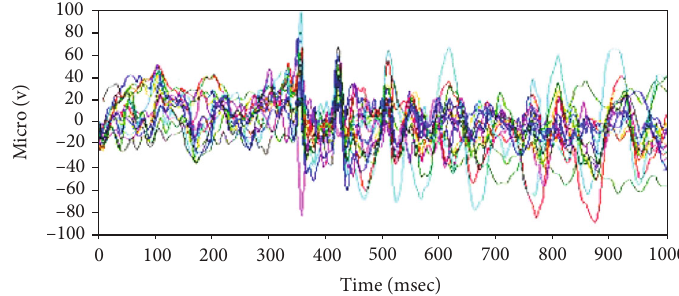
Figure 1: Time series for a subject in the fi rst second when the subject closed the eyes.